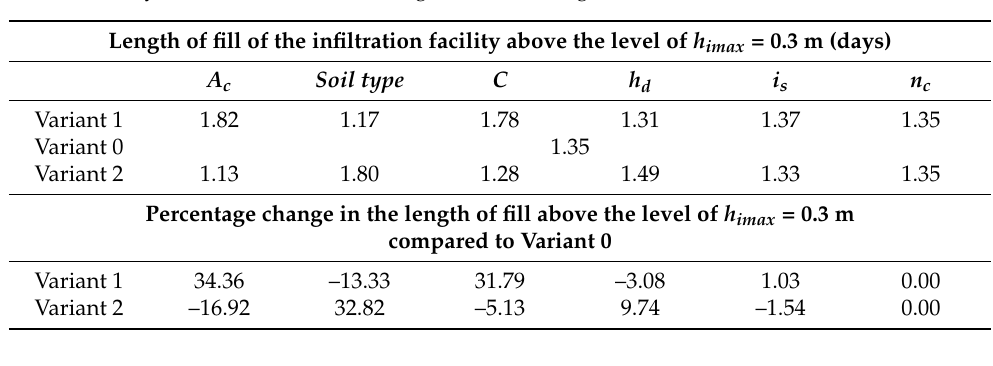
Table A6. The length of fill of the infiltration facility above the value of h imax = 0.3 m in the period from 1 January 2011 to 30 June 2022 (designations as in Figure 2).